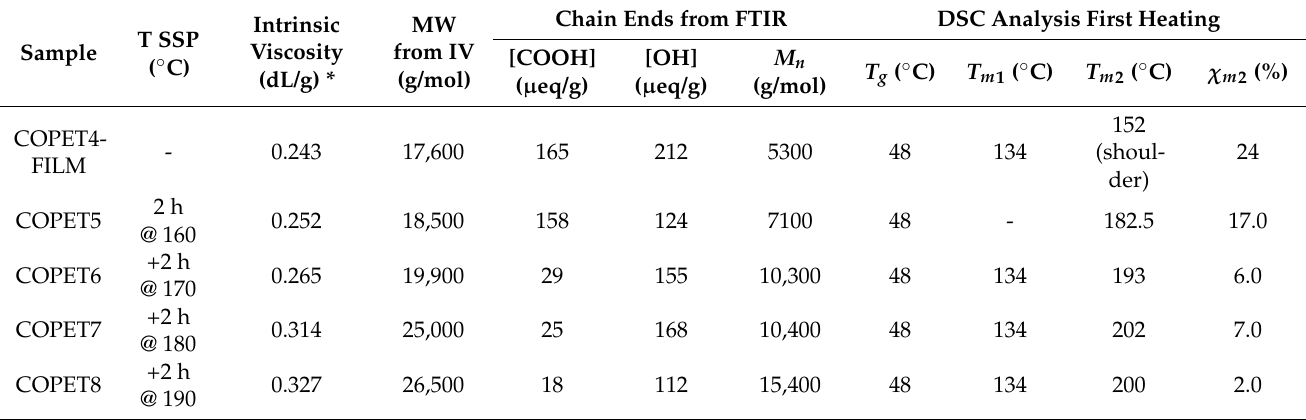
Table 3. Influence of temperature program on S 3 P/SSP